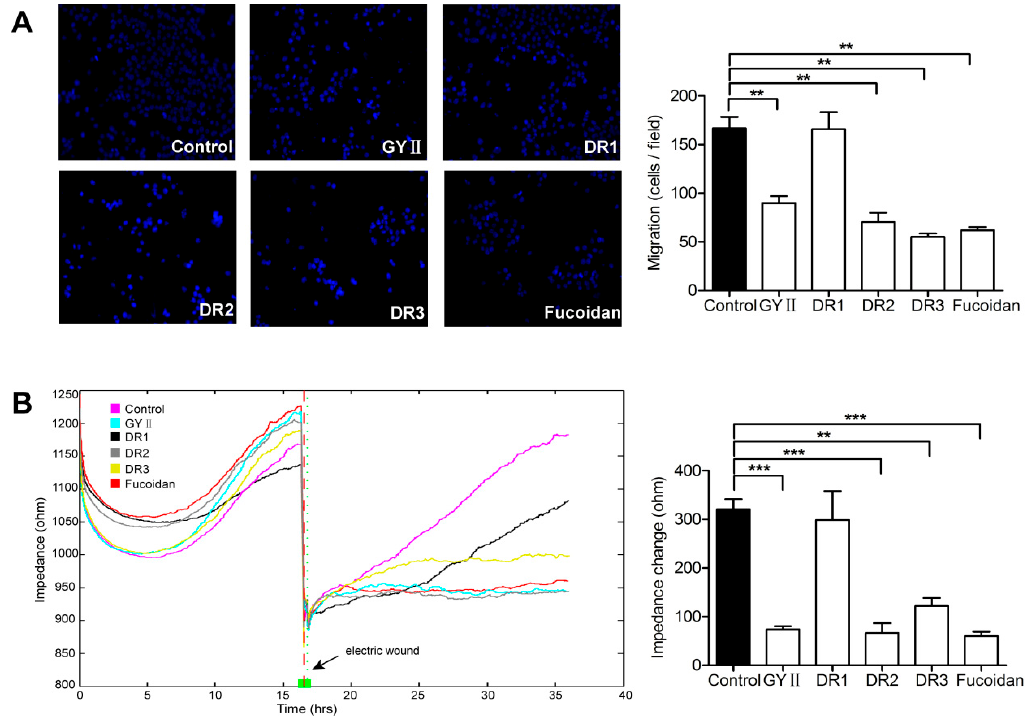
Figure 5. GYII and its decomposed recipes attenuated 4T1 cell migration and wound healing. ( A ) Staining of the Transwell ® membrane with Hoechst 33342 and visualization under a fluorescence microscope (200× magnification). The data presented in the right panel were obtained from three independent experiments by counting five randomly selected fields; ( B ) After seeding the cells, electric cell substrate impedance sensing (ECIS) was applied at 16 h to produce a lesion via electroporation (indicated by the arrows). After washing away the dead cells, fresh medium containing the test compounds were added, and the cell impedance was monitored for 20 h. Impedance changes in 20 h are presented in the right panel as the mean of three experiments (** p < 0.01, *** p < 0.0001).